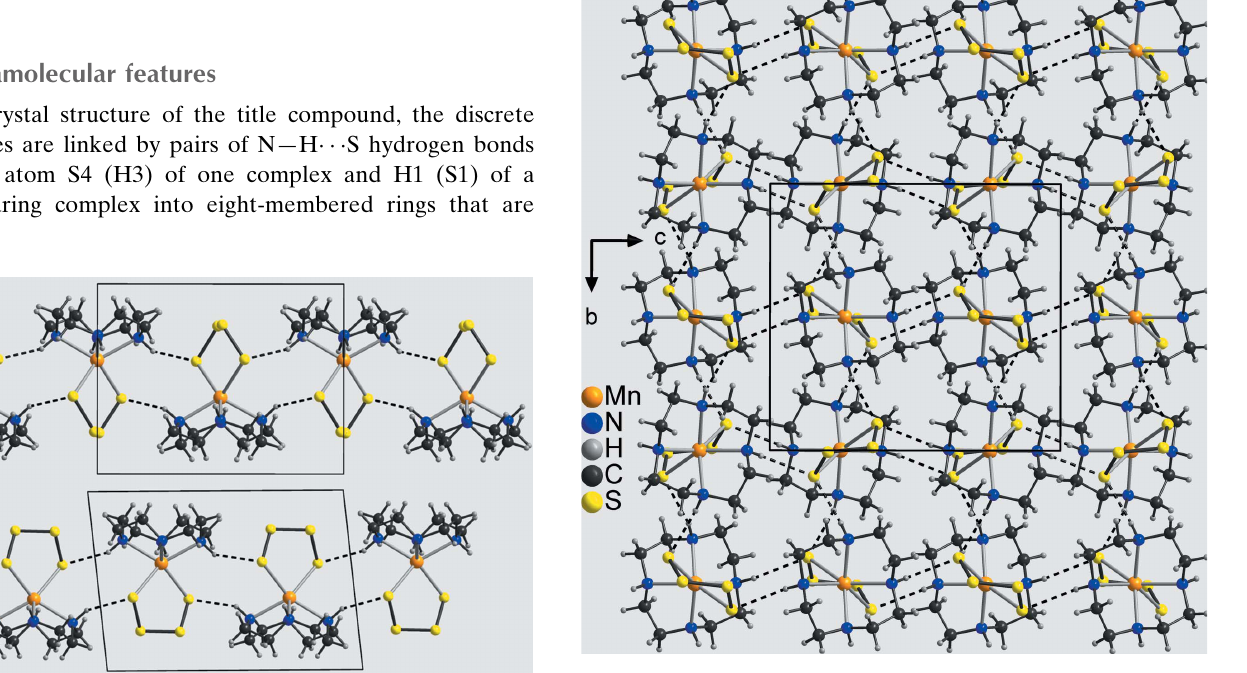
Figure 5 Crystal structure of the title compound with view of the layers along the a -axis direction with intermolecular N—H (cid:2)(cid:2)(cid:2) S hydrogen bonds shown as dashed